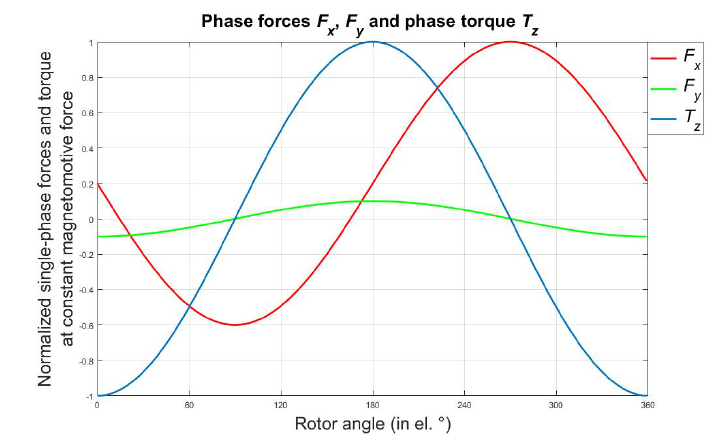
Figure 7. Part of the FSPM with its magnetic flux density.